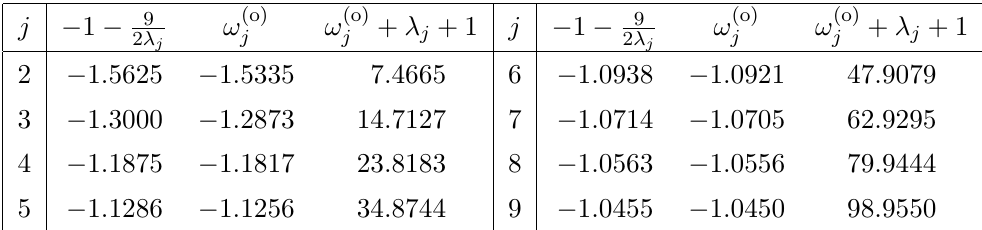
Table 1. Low-lying spectrum of finite-action scalar perturbations, along with the approximation of eq.